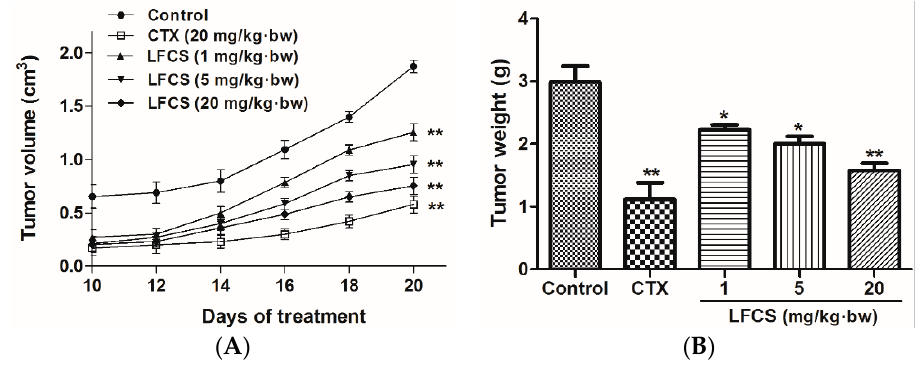
Figure 1. Anti-tumor effects of LFCS on Lewis lung cancer in vivo . LFCS significantly reduced the tumor volume and weight in C57BL/6 mice. ( A ) Tumor growth curves and ( B ) weight of the tumors. Mean weights of the tumors are 2.99 g, 1.12 g, 2.23 g, 2.00 g and 1.58 g, for the control group, CTX group, 1 mg/kg·bw, 5 mg/kg·bw, and 20 mg/kg·bw LFCS group, respectively. Data are represented as mean ± SD ( n = 8). * p < 0.05, ** p < 0.01, significant difference compared with control group (NS group).